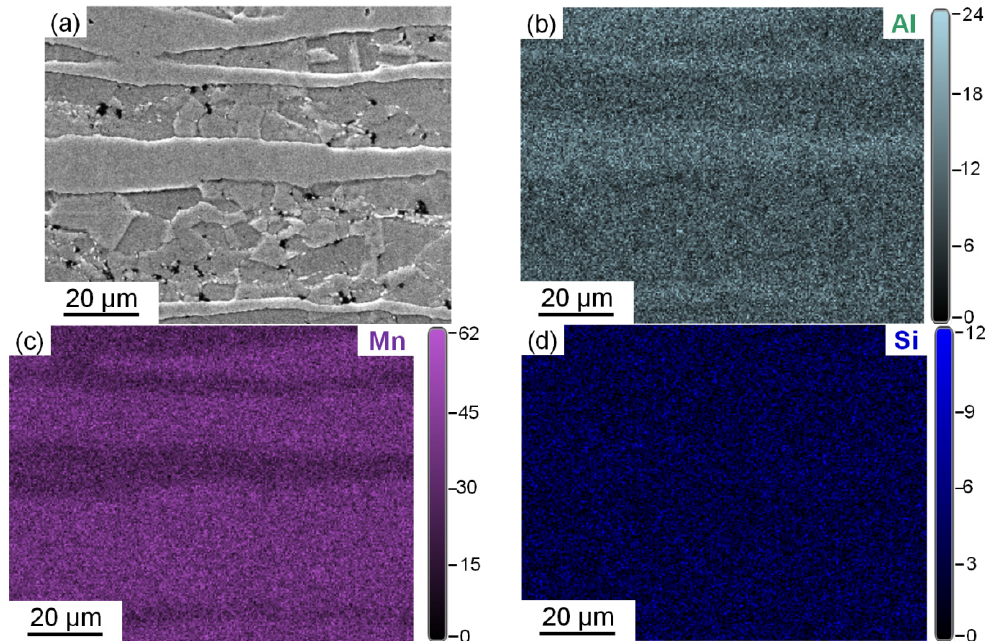
Figure 6. ( a ) Scanning electron micrograph of the microstructure morphology of the sample annealed at 800 °C and EDS mapping images of the distribution of ( b ) Al, ( c ) Mn and ( d ) Si.